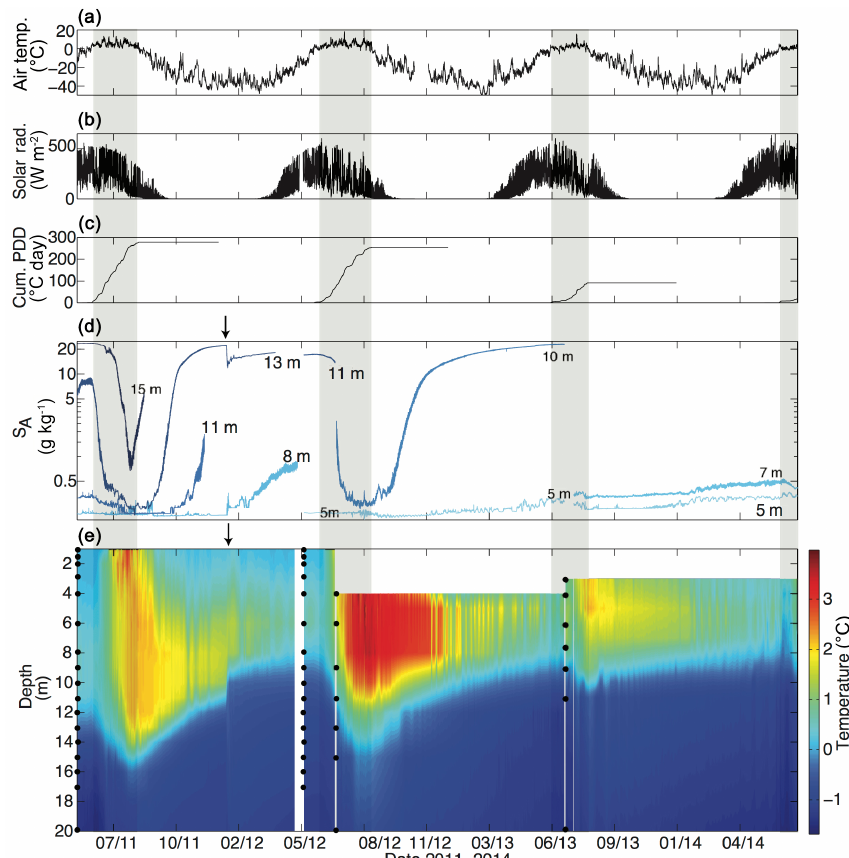
Figure 6. Time series of meteorological conditions and epishelf lake properties from May 2011 to July 2014 in Milne Fiord. (a) Air tem- perature. (b) Shortwave solar radiation. (c) Cumulative positive-degree days (PDDs). (d) Absolute salinity ( S A ) from instruments moored at depths between 5 and 15m. Note the logarithmic scale. (e) Temperature time series from thermistors moored between 1 and 20m depth. Black circles indicate thermistor depths at each mooring deployment, and white areas indicate data gaps. Transparent grey regions mark the start and end of the surface melt season each year. Arrows in (d) and (e) indicate the timing of the mixing event shown in Fig.